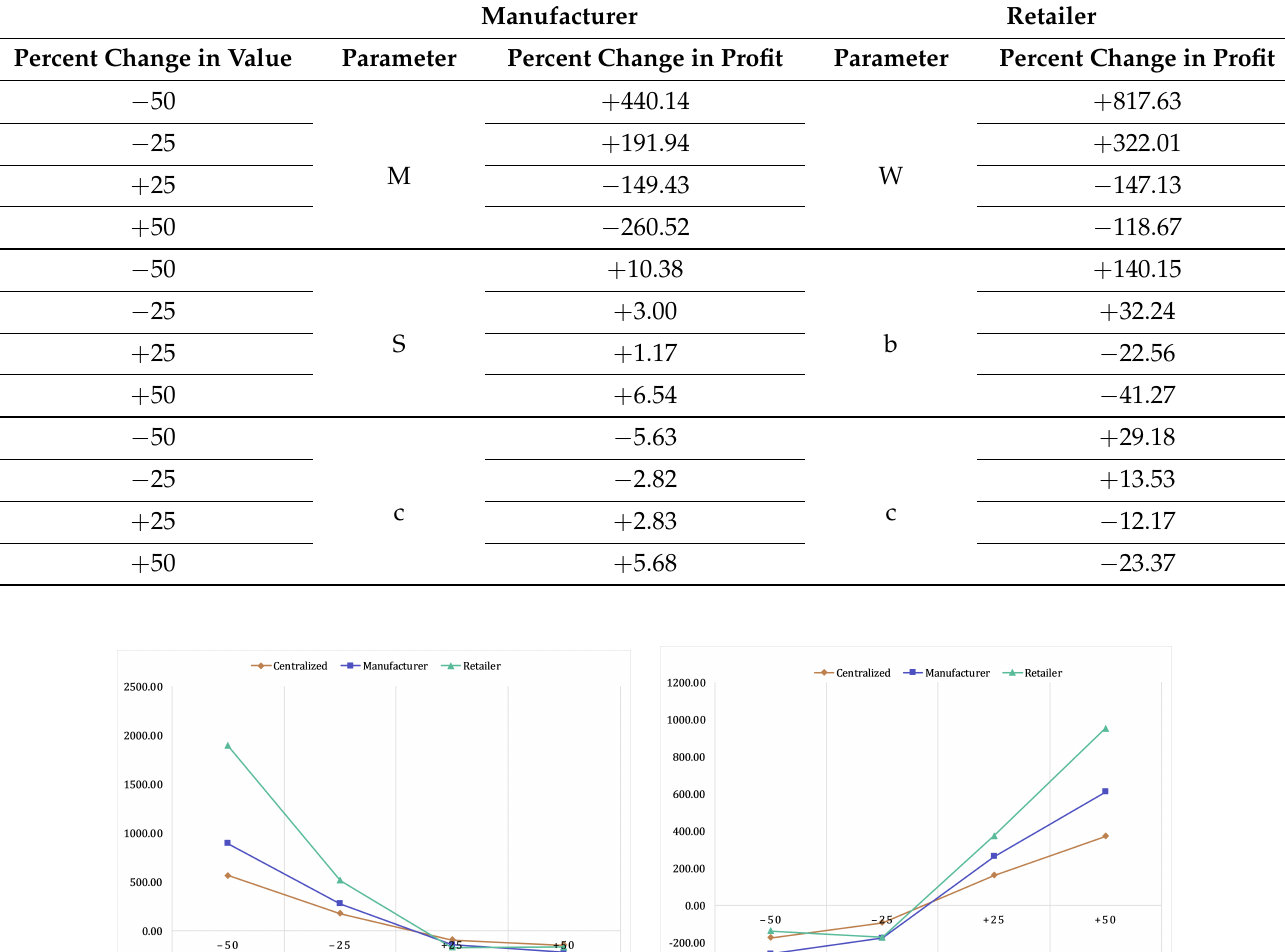
Table 7. Key parameter sensitivity analysis for manufacturer and retailer.